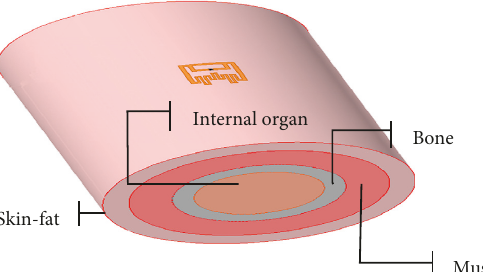
Figure 10: The first proposed tag placed on the layered elliptical model of the human torso: skin-fat axes, 335 × 168mm 2 ; muscle ellipse axes, 310 × 142mm 2 ; bone ellipse axes, 284 × 105mm 2 ; in- ternal organ, 272 × 84 mm 2 at 870MHz.